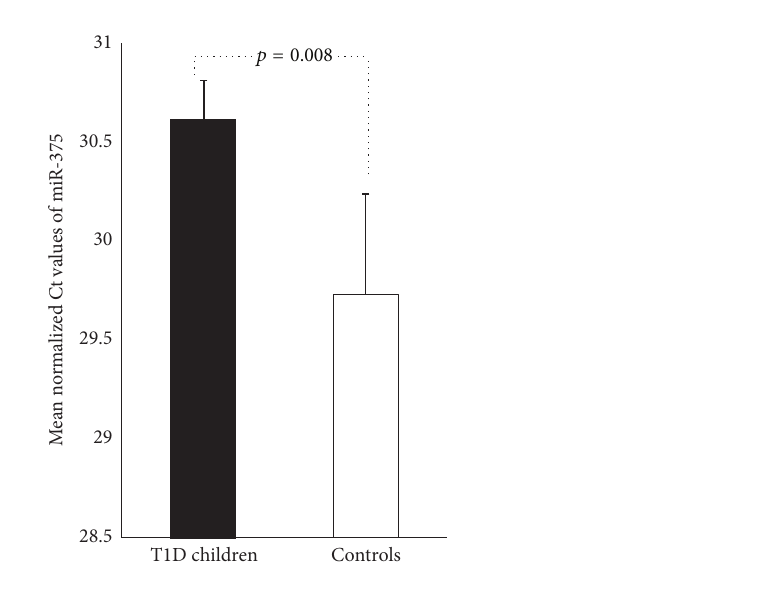
Figure 1: Quantification of miR-375 in sera of newly diagnosed T1D children. Data are expressed as Ct values. The Ct is defined as the number of cycles required for the fluorescent signal to cross the threshold (i.e. exceeding background level). Ct levels are inversely proportional to the amount of target nucleic acid in the sample (i.e. the lower the Ct level, the greater the amount of target nucleic acid in the sample). To analyze individual qPCR data, we first controlled the quality of RNA extraction by quantifying Cel-miR-39 (spike). The following formula was used for normalizing the Ct values of miR-375 in all sera samples: raw Ct value − [(spike-in average Ct value of sample) − (median spike-in Ct)]. Data are expressed as mean values ± SEM.